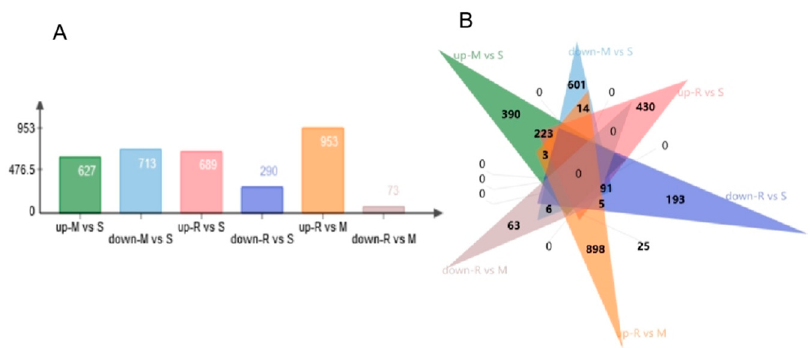
Figure 2. DEGs between the different testis developmental stages. ( A ) Summary of DEGs. The x-axis represents compared samples. The y-axis represents DEG numbers. ( B ) The Jvenn diagram of the number of differential up- and down-regulated genes in different reproductive phases.